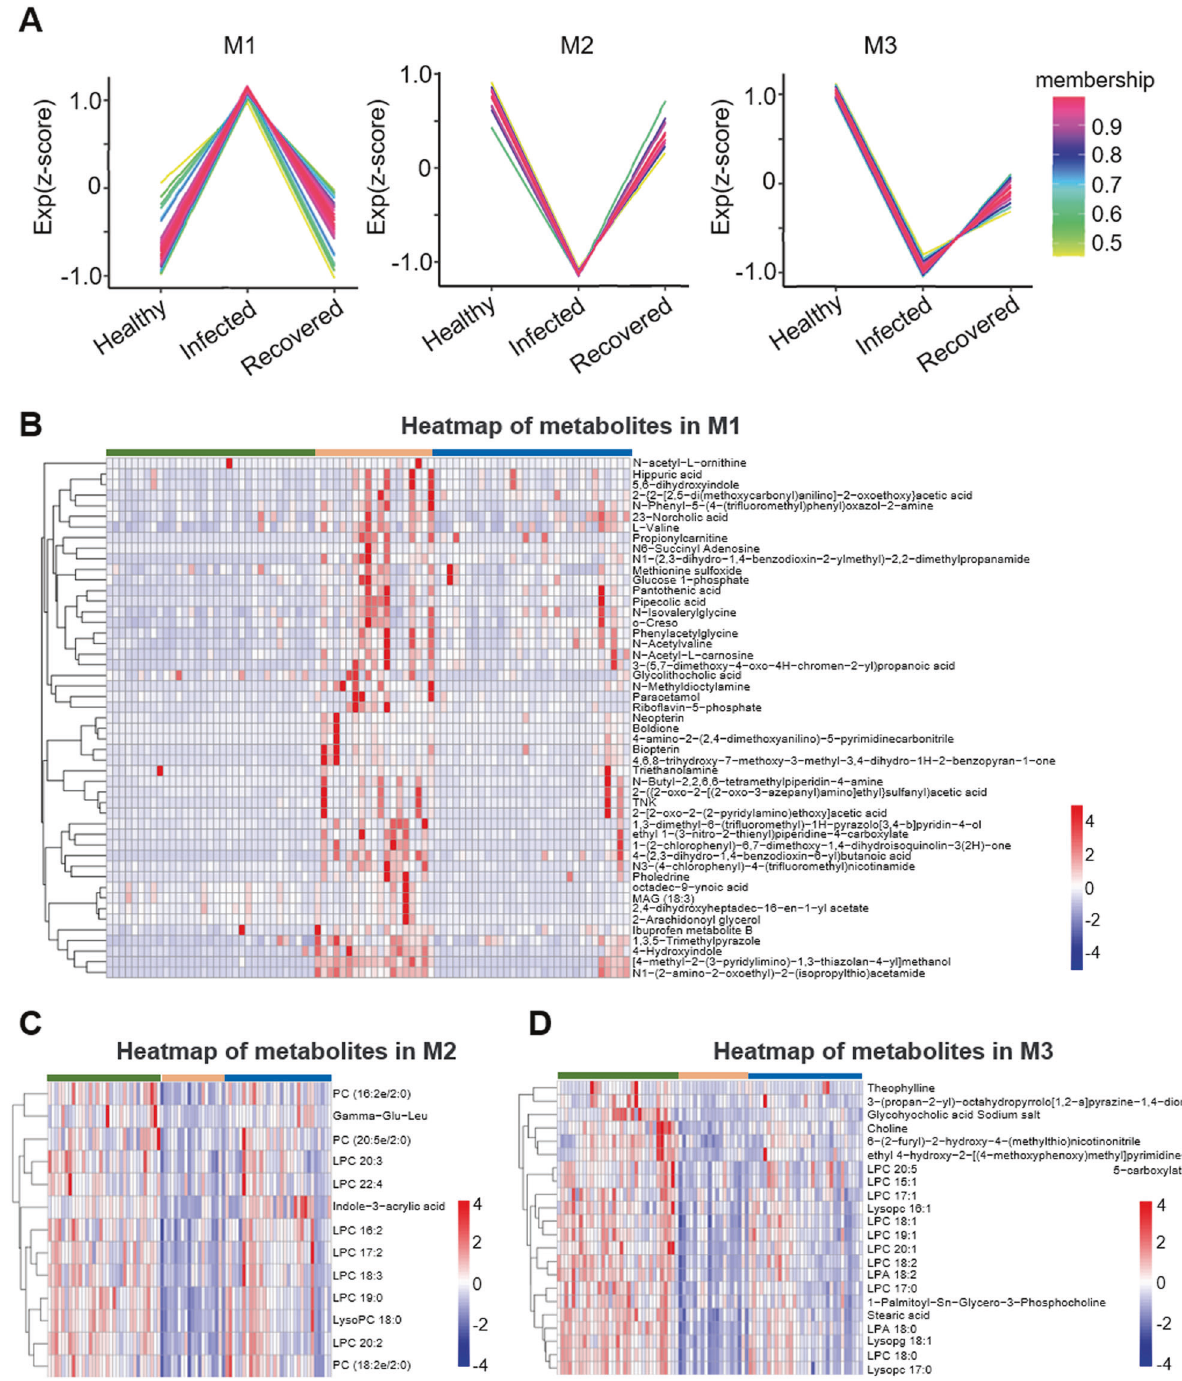
Fig. 4 Expression pro fi les were analyzed according to metabolic abundance between patients with COVID-19 and healthy participants. A The result of cluster analysis in processing conditions (Healthy-Infected-Recovered) by the Mfuzz package, M1 – M3. The color bar represents the Z score change from − 1 to 1. B – D Heatmap visualization of metabolites in M1 – M3 under the processing conditions (healthy, infected, recovered). The color bar represents the relative intensity of identi fi ed metabolites from − 4 to